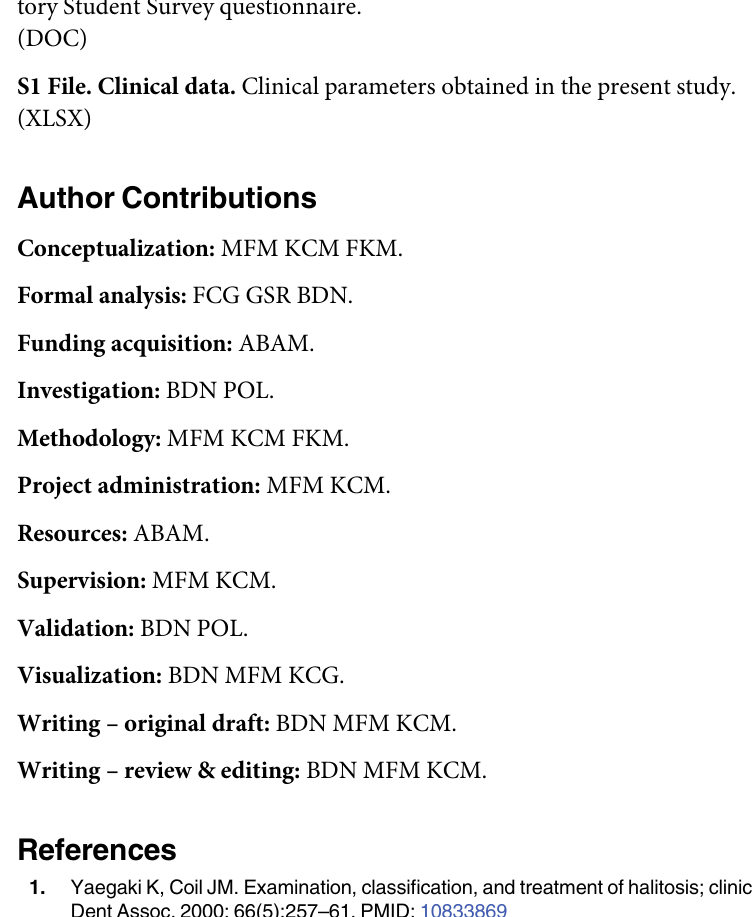
S1 Fig. English MBI-SS questionnaire. English version of the Maslach Burnout Inventory Student Survey questionnaire. S2 Fig. Portuguese MBI-SS questionnaire. Portuguese version of the Maslach Burnout Inven- tory Student Survey questionnaire. S1 File. Clinical data. Clinical parameters obtained in the present